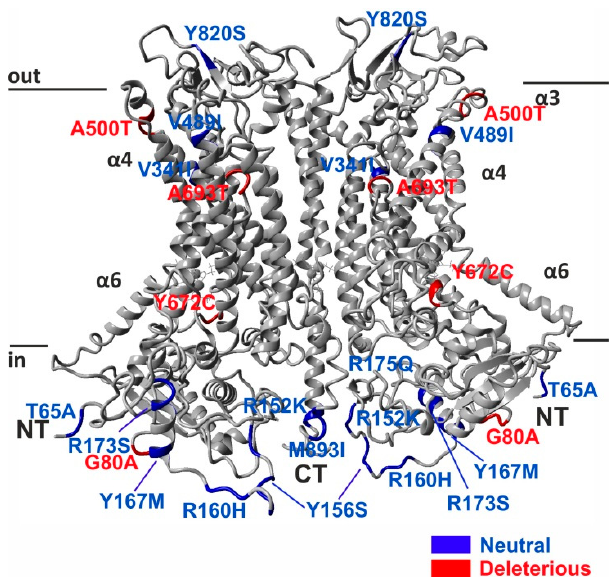
Figure 2. Identification of deleterious nsSNPs in human ANO4 gene. Non-deleterious (blue) and deleterious (red) nsSNPs were mapped to the structure of human ANO4 protein structure obtained from homology modeling.